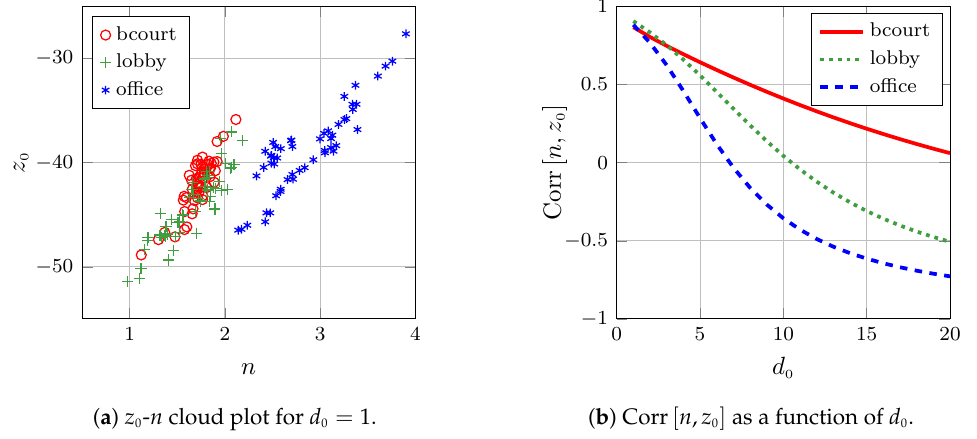
Figure 8. Correlation between z